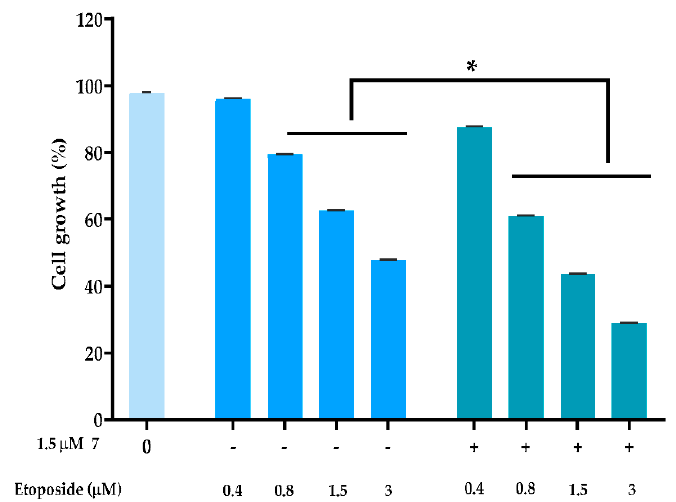
(Table 2). Of note, for the same experimental conditions used in MDA-MB-231 cells, no synergistic effects were observed in HFF-1 cells (Table 2).